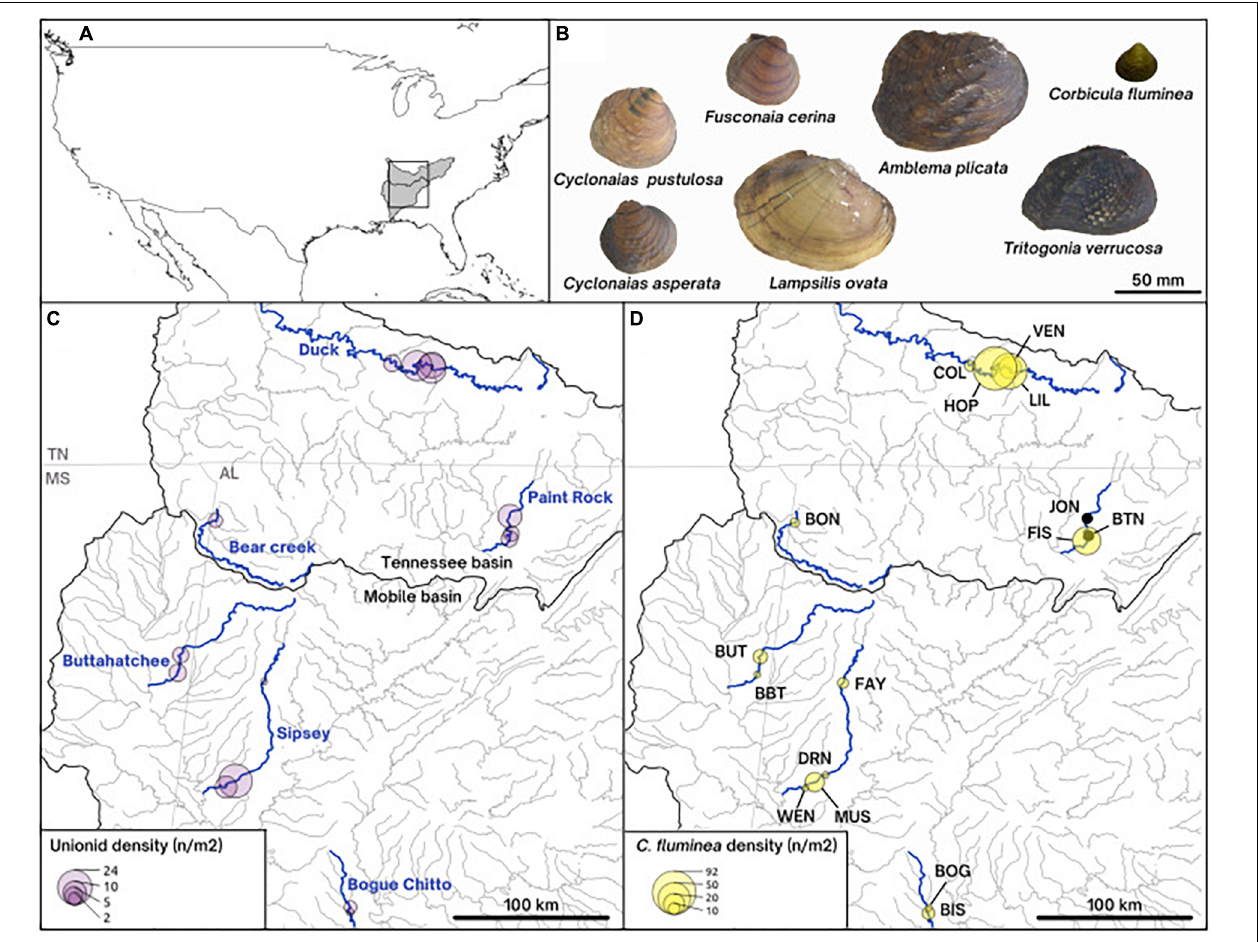
FIGURE 1 | Map of the collecting sites (A,C,D) and pictures of the shells (B) of the species studied. (A) Overall map of the United States of America, showing the Mobile and the Tennessee river basins shaded in gray. (C) Density of unionids on our collecting sites along the six rivers of study. (D) Density of the invasive Asian clam Corbicula fluminea on collecting sites and site names represented by three letters. (B) On-scale pictures of representative shells of the native unionid species included in this paper ( Lampsilis ovata , Cyclonaias pustulosa , Cyclonaias asperata , Fusconaia cerina , Tritogonia verrucosa , and Amblema plicata ) and the invasive Corbicula fluminea